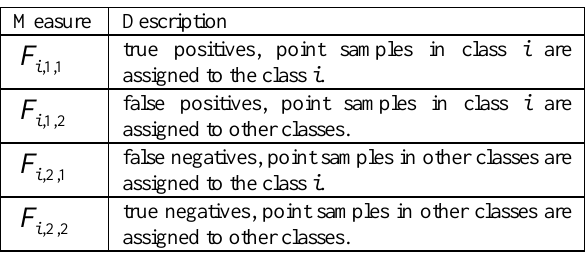
Table 3. Four common measures. From the four measures in Table 3 three evaluation measures can be